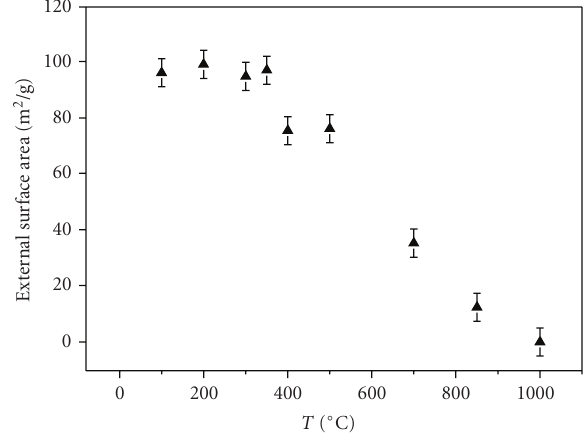
Figure 3: BET surface area versus temperature of the thermal treatment of the samples.